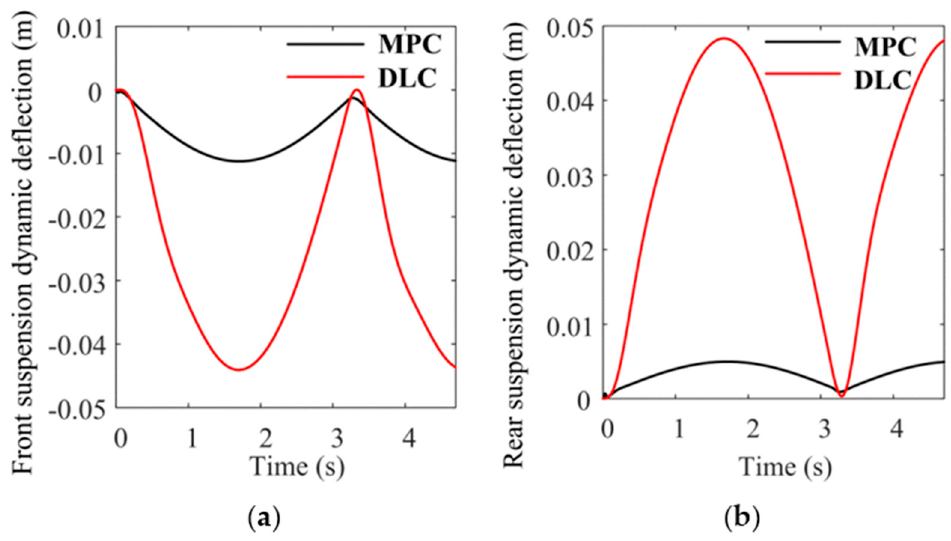
Figure 10. Suspension dynamic deflection. ( a ) Front suspension dynamic deflection; ( b ) Rear suspension dynamic deflection.